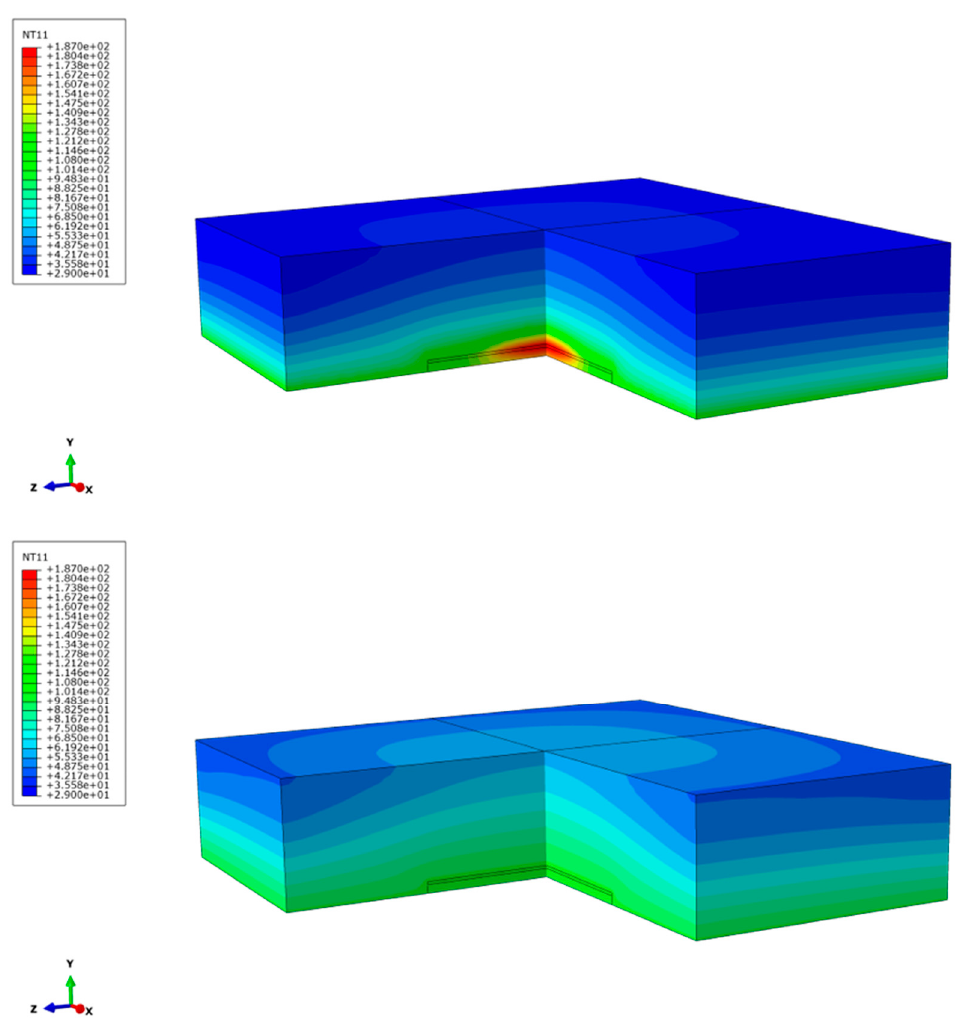
Figure 9. ( Top ) Resulting temperature field immediately after the last loading step for the layer-wise measured epoxy data. ( Bottom ) Resulting temperature field at the end of the last unloading step for the layer-wise measured epoxy data.